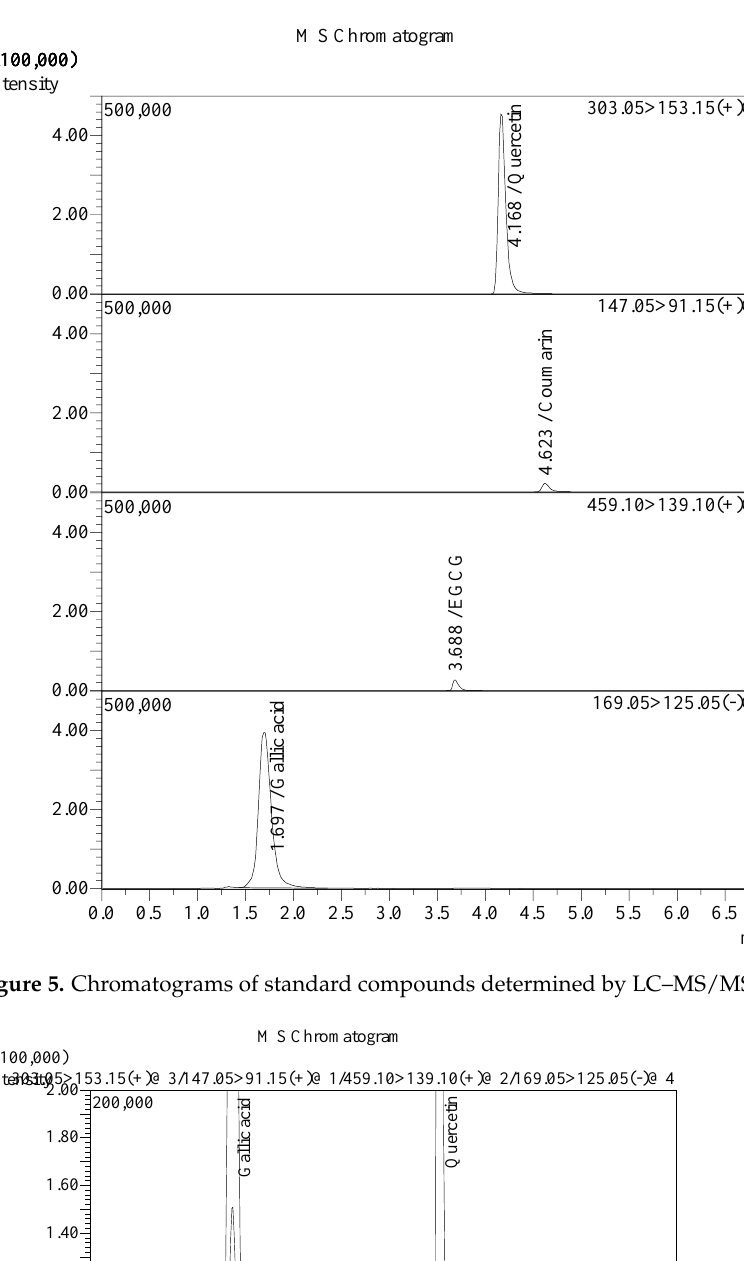
Figure 4. LC–MS/MS analysis presenting the precursor ion and product ion spectra of ( A ) coumarin, ( B ) gallic acid, ( C ) EGCG, and ( D ) quercetin.